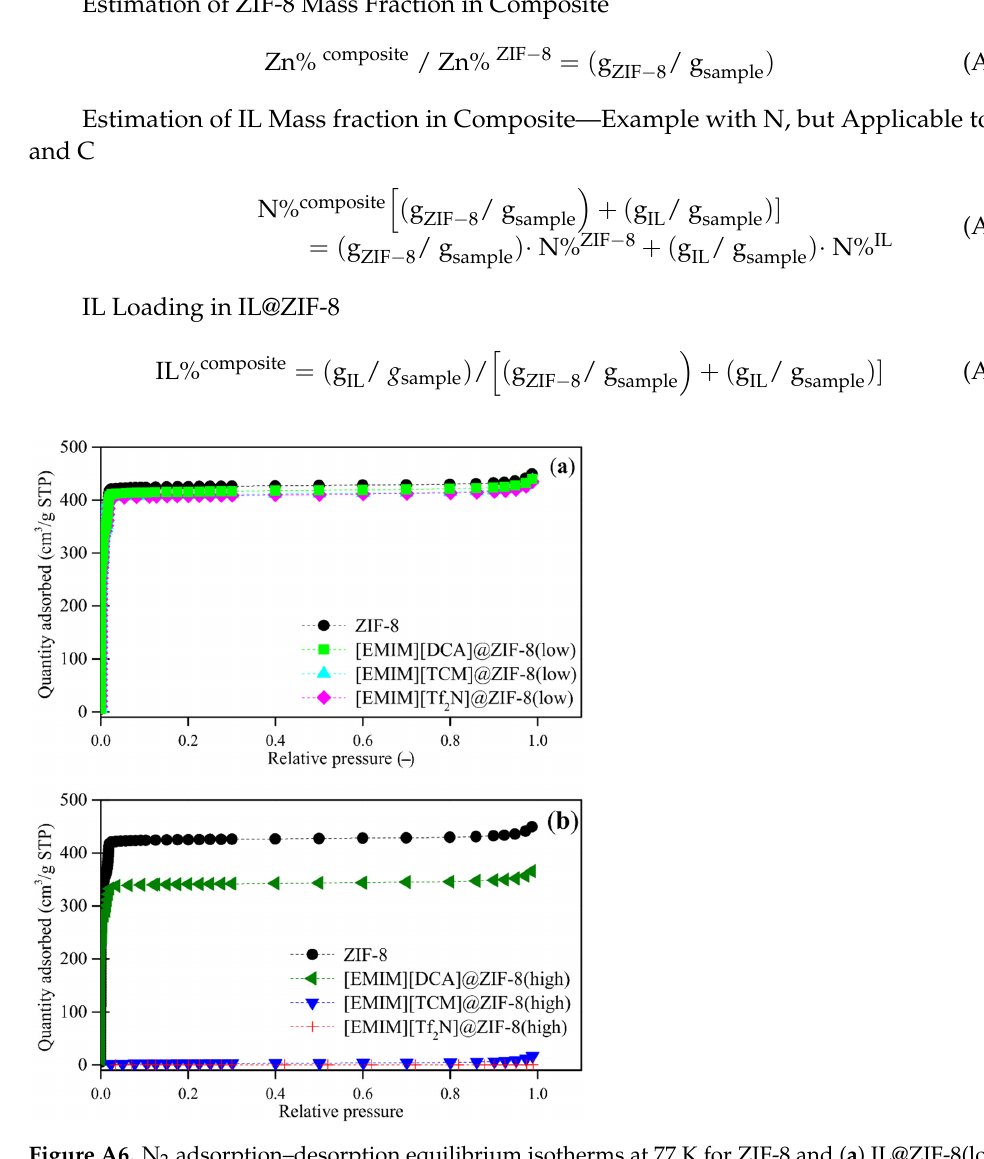
Figure A6. N 2 adsorption–desorption equilibrium isotherms at 77 K for ZIF-8 and ( a ) IL@ZIF-8(low) and ( b ) IL@ZIF-8(high) composites.